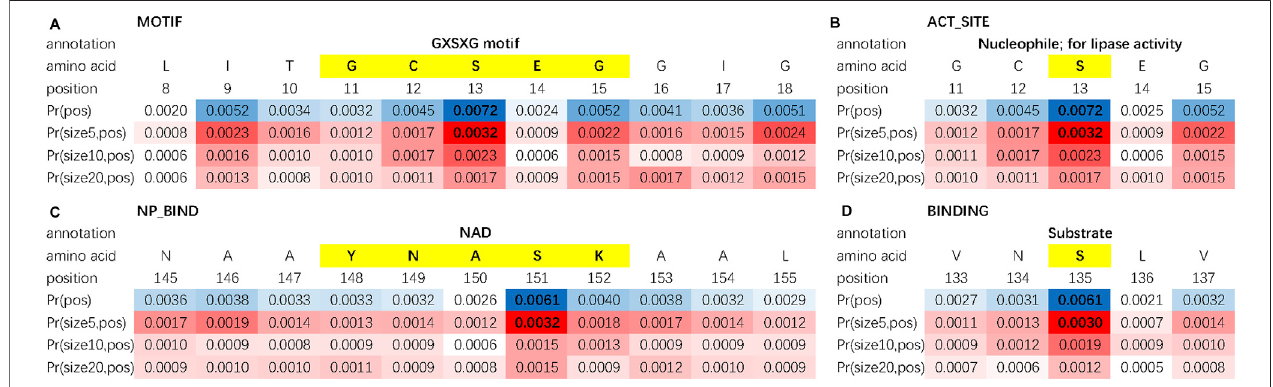
FIGURE 4 | Matched sites and regions of AYR1_SCHPO. (A) Motif. (B) Amino acid involved in the enzymatic activity. (C) Binding site. (D) Extent of a nucleotide phosphate-binding